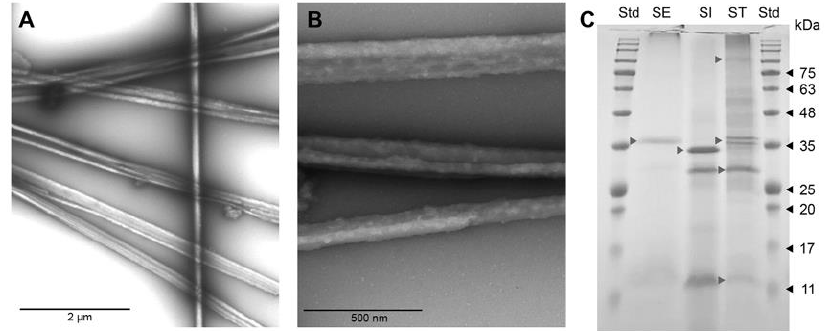
Figure 1. Transmission electron microscopy of cochleates derived from Salmonella -forming filamentous structures; ( A ) 9600 × magnification, ( B ) 43,000 × magnification, ( C ) SDS–PAGE 15% from cochleates formulated with Salmonella Enteritidis (SE), Salmonella Infantis (SI) and Salmonella Typhimurium (ST). Gray arrows show the main membrane proteins for each serotype. Black arrows indicate the molecular weights of AccuRuler RGB Plus Prestained Protein Ladder weight standard (Std) (Maestrogen, Taiwan, China).